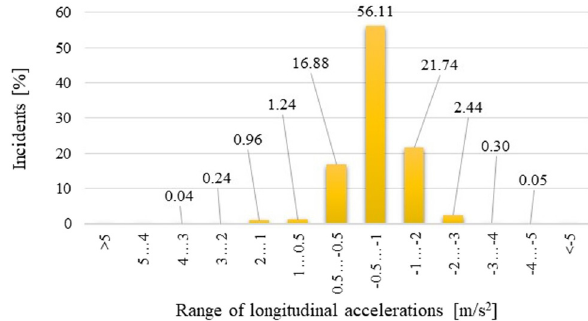
Figure 11: The frequency of occurrence of particular values of long - itudinal acceleration – morning